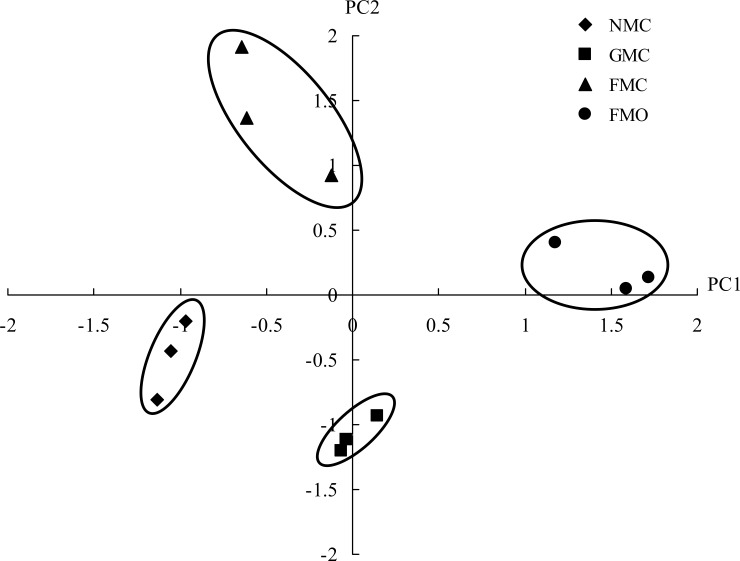
Principal component analysis of CLPP results from maize rhizosphere soil treated with different mulching and fertilizer treatments.Soil samples were tested from rhizosphere of maize treated with different mulching and fertilizer treatments.